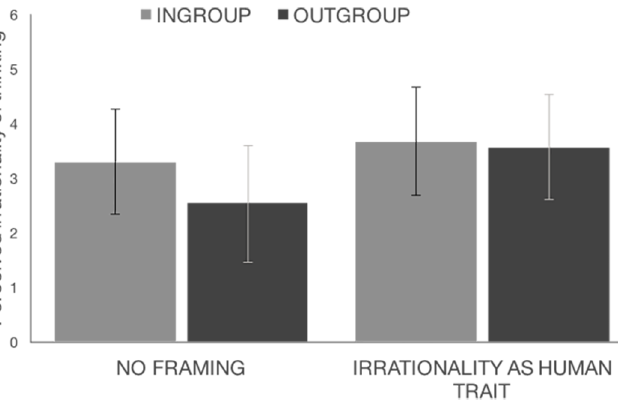
Figure 1. Evaluation of the target person in no framing and irrationality as human trait conditions as a function of the target person’s membership, the Turkish sample in Study 1. Note. Error bars represent standard deviations ( SD